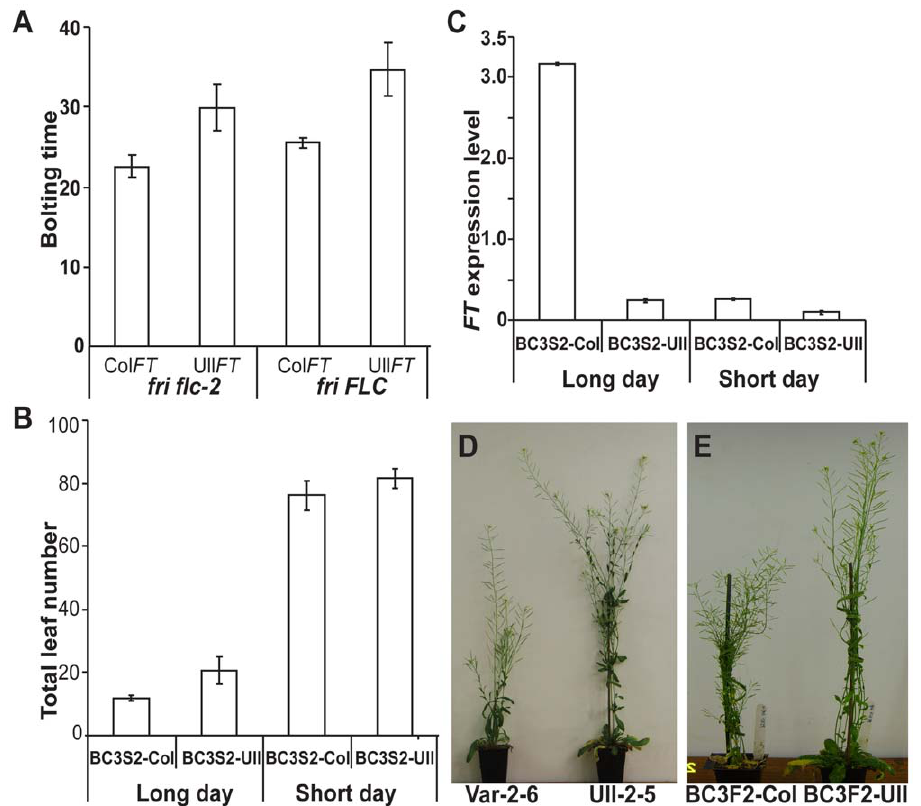
Figure 3. Functional analysis of the Ull-2-5 FT allele using backcrossed populations. (A) Comparison of the contribution of Ull-2-5 and Col- 0 FT alleles to flowering time with or without a functional FLC. (B) Comparison of flowering time between BC3S2-Ull and BC3S2-Col in long and short day growth conditions. (C) FT expression of Col-0 and Ull-2-5 alleles in response to different day lengths (D) Final size of plants vernalized for 10 weeks and then grown in a greenhouse. (E) Plant size of BC3S2-Col (left) and BC3S2-Ull (right) in long day growth condition. Error bars in (A) show S. D. of 20 individual plants, in (B) and (C) they show S. D. from three experimental replicates.